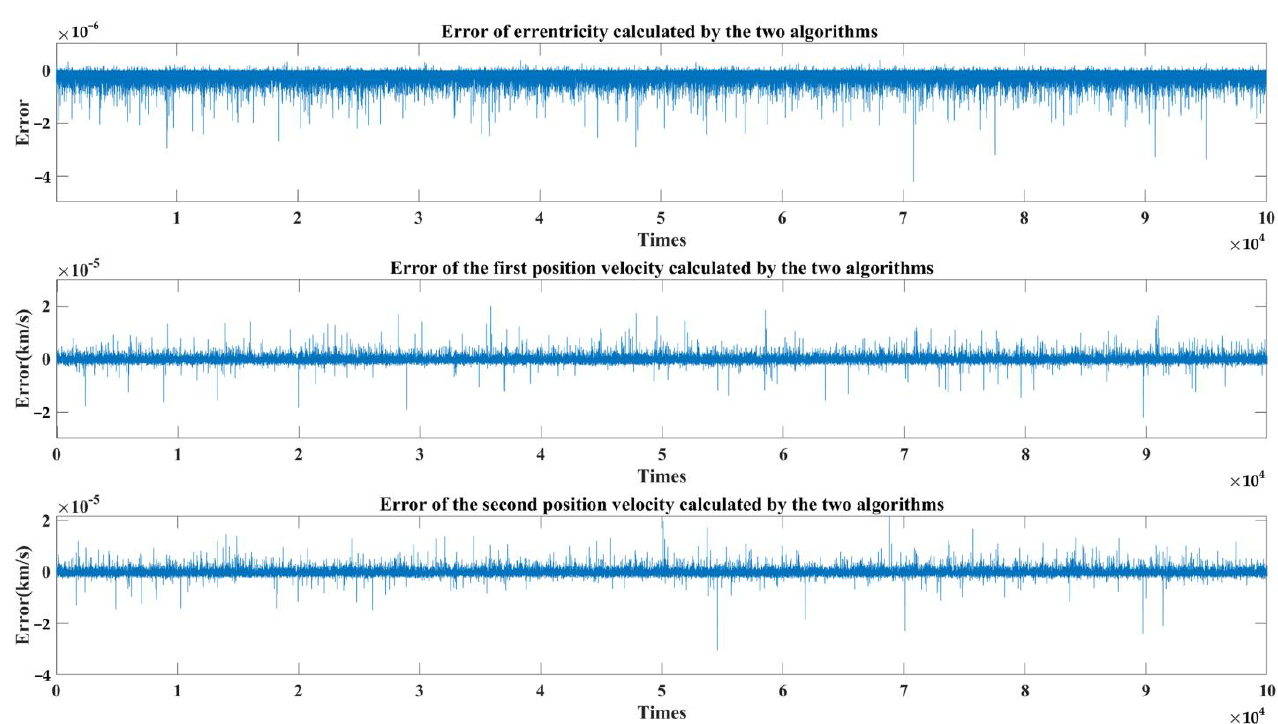
Figure 7. The computational error between the universal variable method and our method.